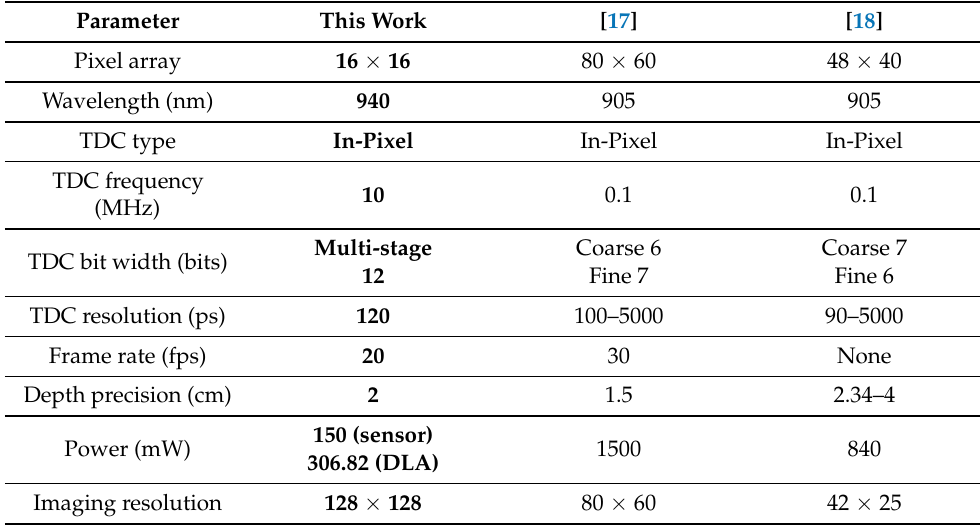
Table 2. System performance summary and comparison